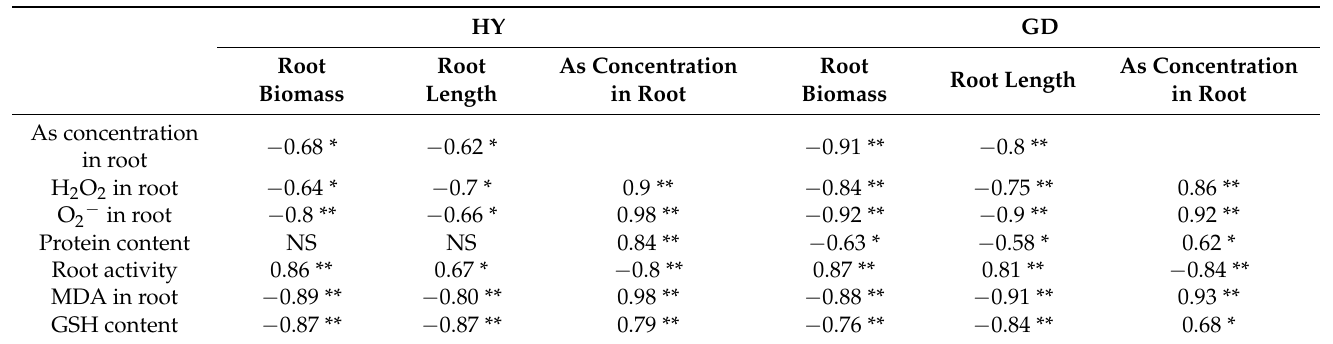
Table 2. Pearson correlation coefficients between root biomass, length, As concentration and H 2 O 2 , O 2 − , protein, MDA, GSH contents in the root, and root